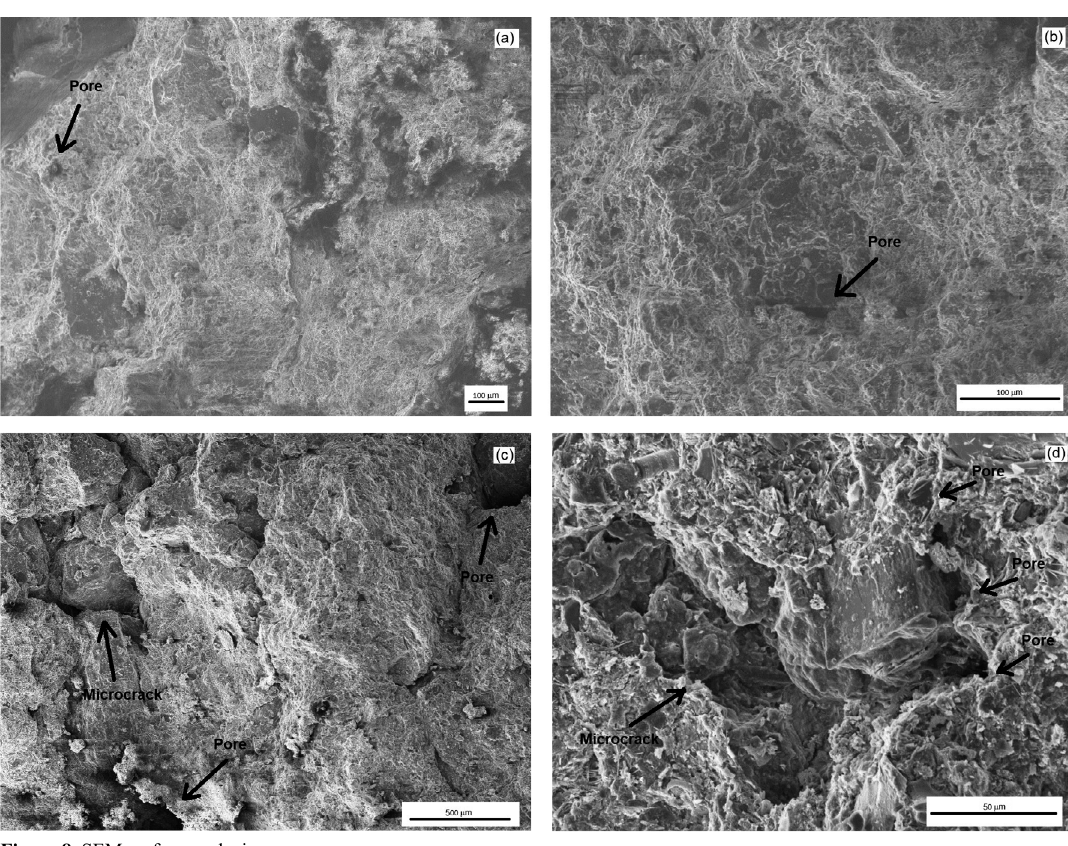
the sample displays through the matrix/aggregate transition zone evidence of low adhesion, which justify the presence of microcracks and pores indicated by